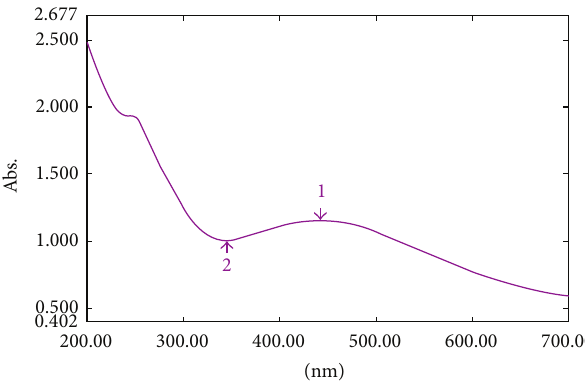
Figure 1: UV-Vis absorption spectra of AgNPs synthesised from S. platensis .